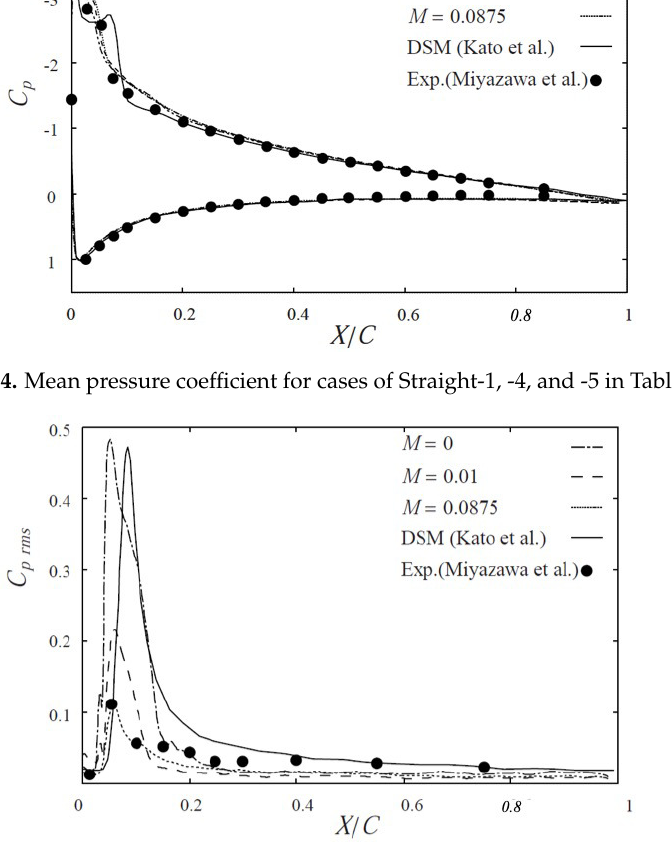
Figure 5. Mean fluctuation of pressure coefficient for cases of Straight-1, -4, and -5 in Table